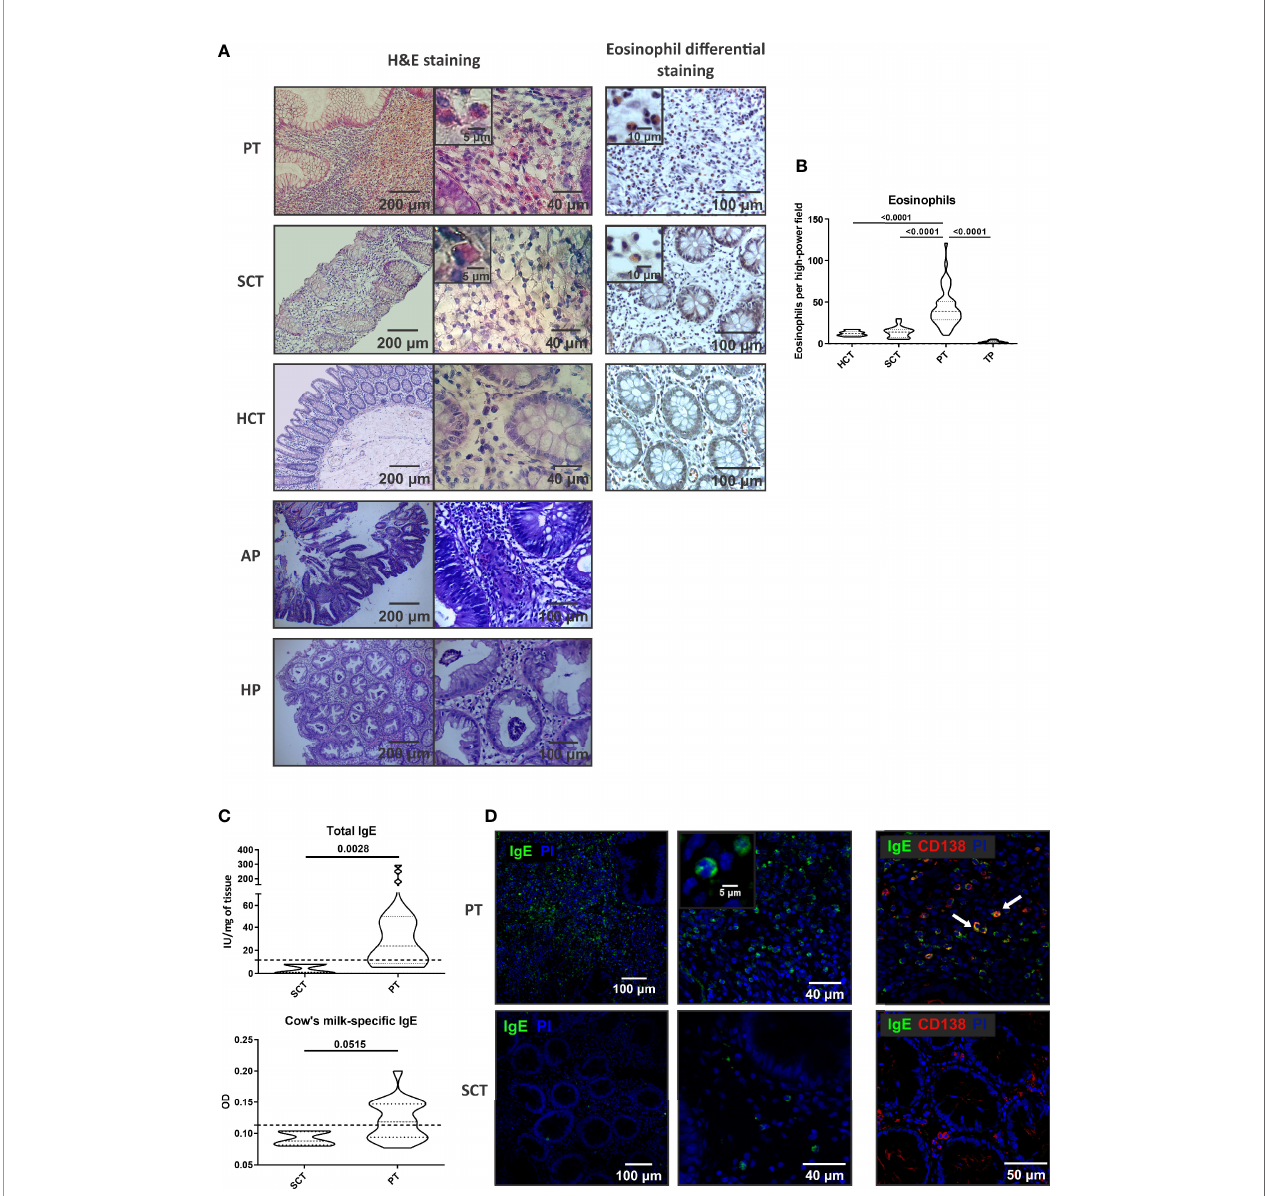
FIGURE 1 | Cell in fi ltrate and IgE in the stroma of colorectal polyps. (A) Histology by H&E and eosin staining of tissue sections from polyp tissues (PT), surrounding control tissue (SCT) and heathy control tissue (HCT). Adenomatous polyps (AP) and hyperplastic polyps (HP) stained with H&E are also depicted. Representative images are depicted. (B) Eosinophil count in colonic tissues from pediatric patients and from adults with tumoral polyps (TP). (C) Total and milk-speci fi c IgE quanti fi cation in the tissues. (D) IgE and CD138 staining by confocal microscopy in the tissues (double- staining are marked with arrows and it corresponds to IgE- expressing plasma cells). Data are expressed as the mean value ± SEM. Statistic differences were calculated using Student´s t